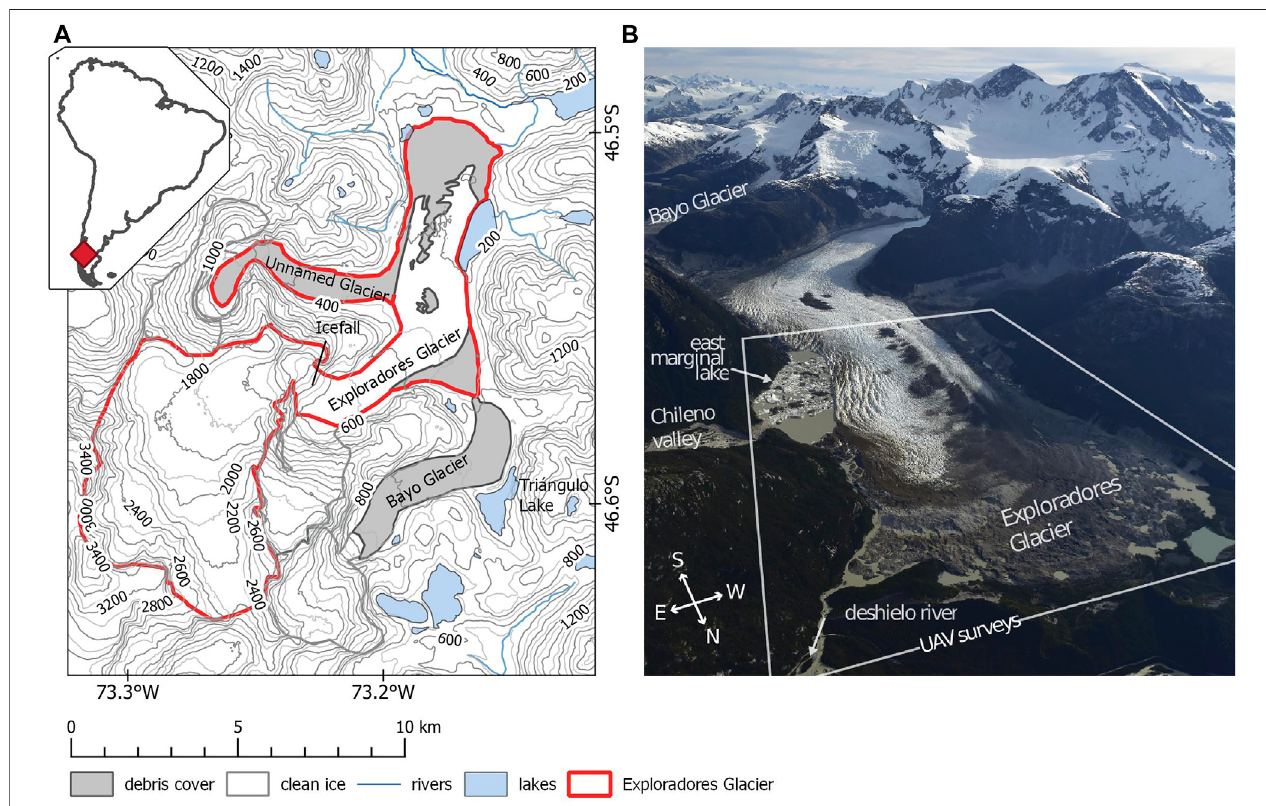
FIGURE1|(A) ExploradoresGlacier(WGS84). (B) AerialphotoofExploradoresGlacier(credittoGuyWenborne).HighestpeakcorrespondstoMountSt.Valentín (4,032 m